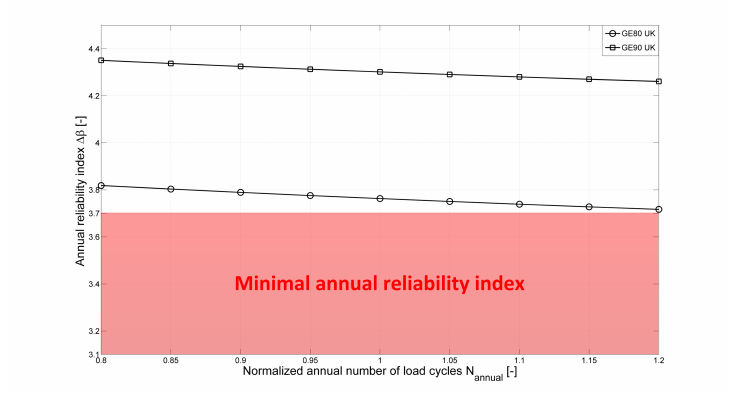
Figure 14. Annual reliability index when changing the annual number of cycles between 80% and 120% of the originally determined N annual . The mean value crack size a is set equal to 0.15 mm, the expected friction coefficient equal to 0.15 and the COV value of X WL equal to